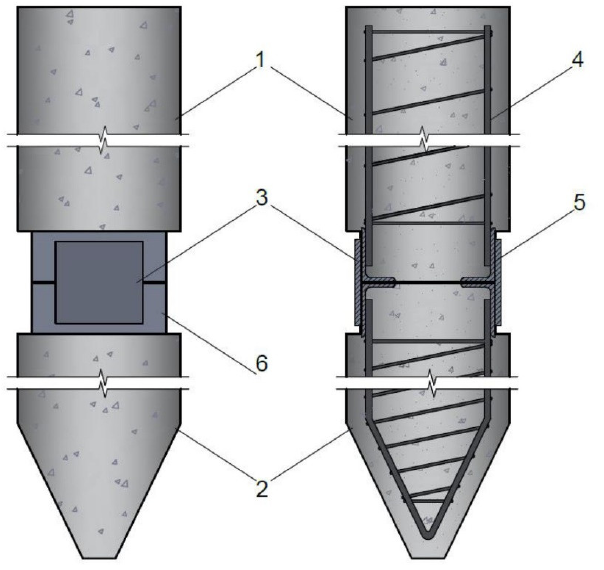
Figure 1. Driven precast pile (plan view and section): 1—upper section, 2—bottom section, 3—steel plate, 4—reinforcement cage, 5—steel angles, 6—corrosion-resistant coating.